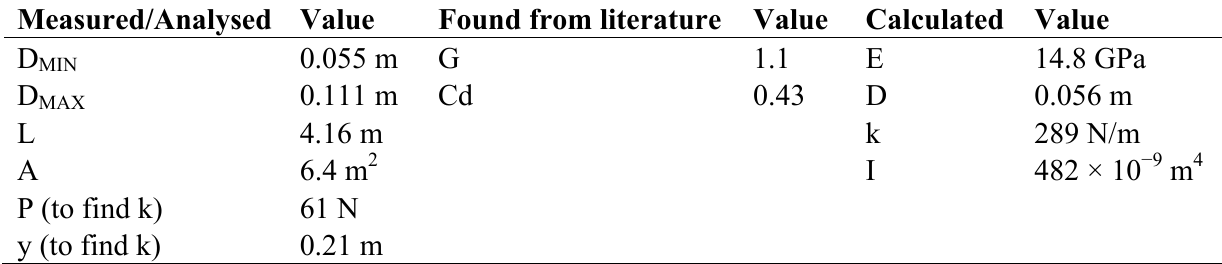
Table 1. Data for experimental tree.